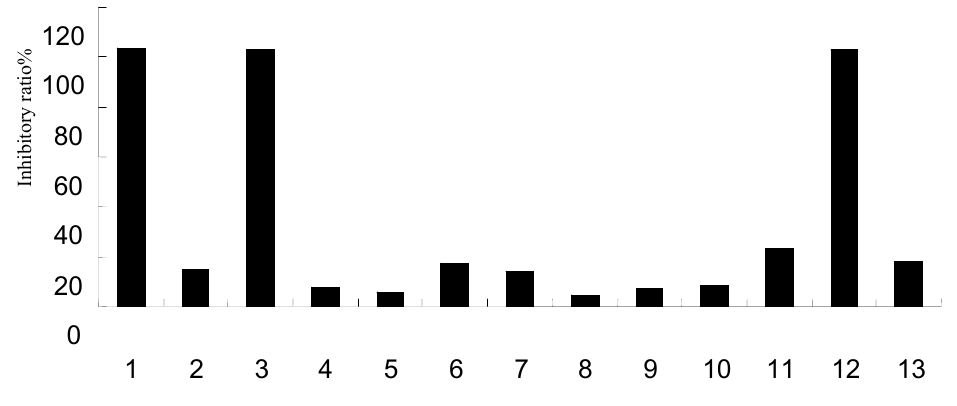
Figure 2. Primary screening results of components on NA activity.